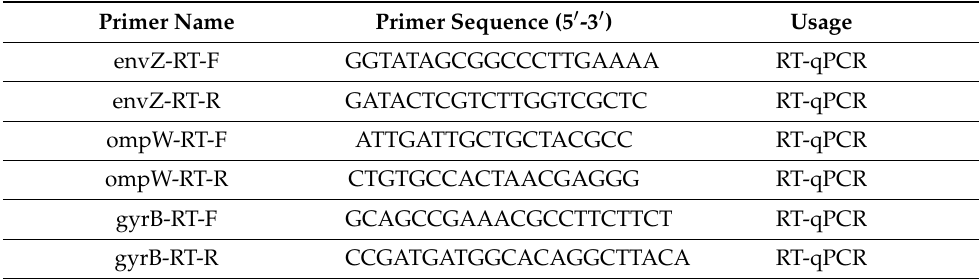
Table 2. The primer sequences used in this